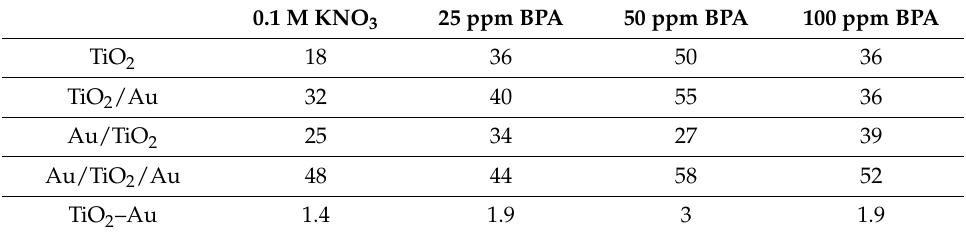
Table 4. Photocurrent density ( µ A/cm 2 ) measured at constant applied potential of 0.5 V vs SCE, in supporting electrolyte and in differently concentrated BPA solutions for the different